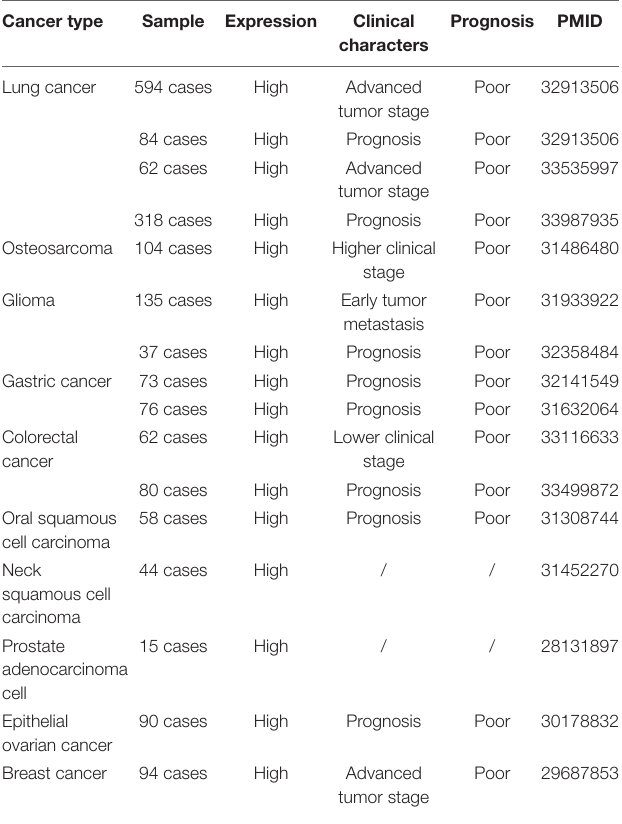
TABLE 1 | Expression and effect on clinical characters of LINC01116 in different cancer